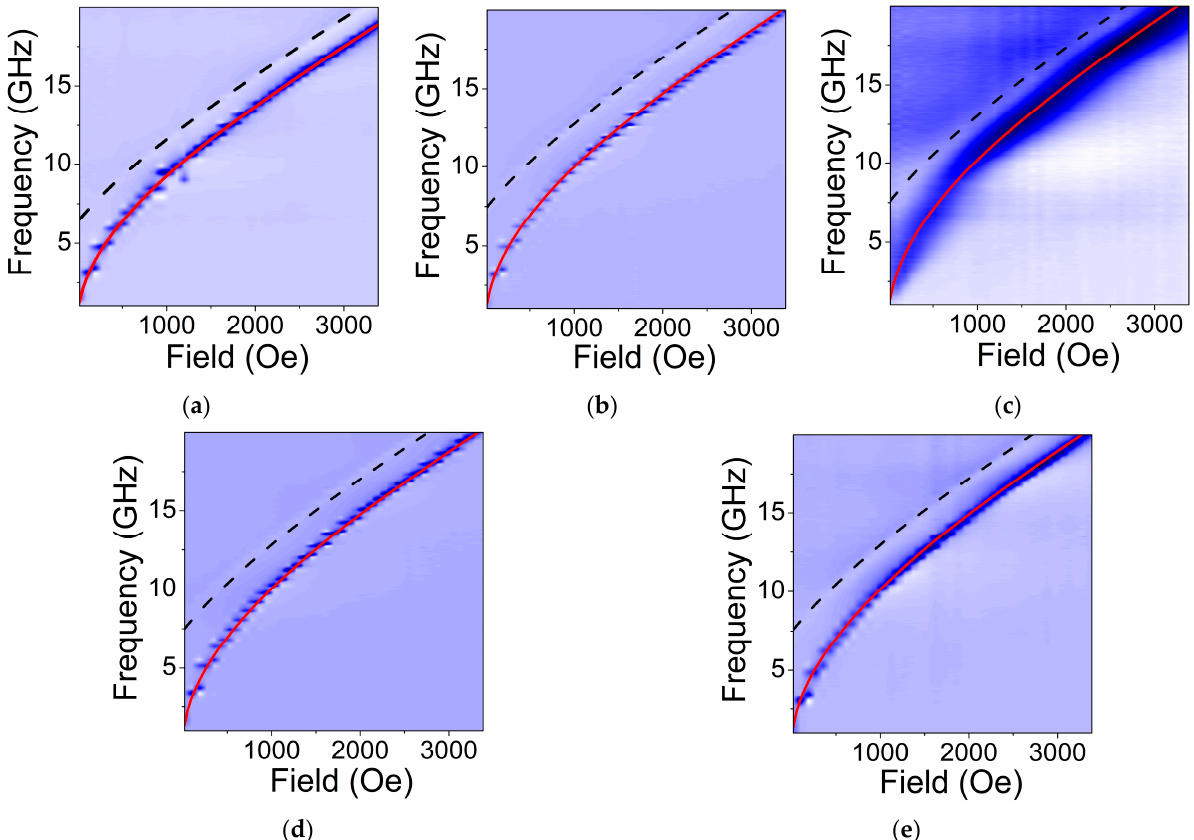
Figure 5. Dependencies of the FMR frequency and the first order PSSW on applied magnetic field for Co 2 FeGe films deposited at various conditions: ( a ) T S = RT; ( b ) T S = 573 K; ( c ) T S = 773 K; ( d ) T S = RT+ annealing at T a = 573 K for 1 h; ( e ) T S = RT+ annealing at T a = 773 K for 1 h. Solid red lines represent fit of the experimental data for FMR using Equation (2). Dashed lines represent fit for the first order PSSW using Equation (3). The values of effective magnetization M ef f and the exchange stiffness constant 𝐴 extracted from the fitting are listed in Table 2.